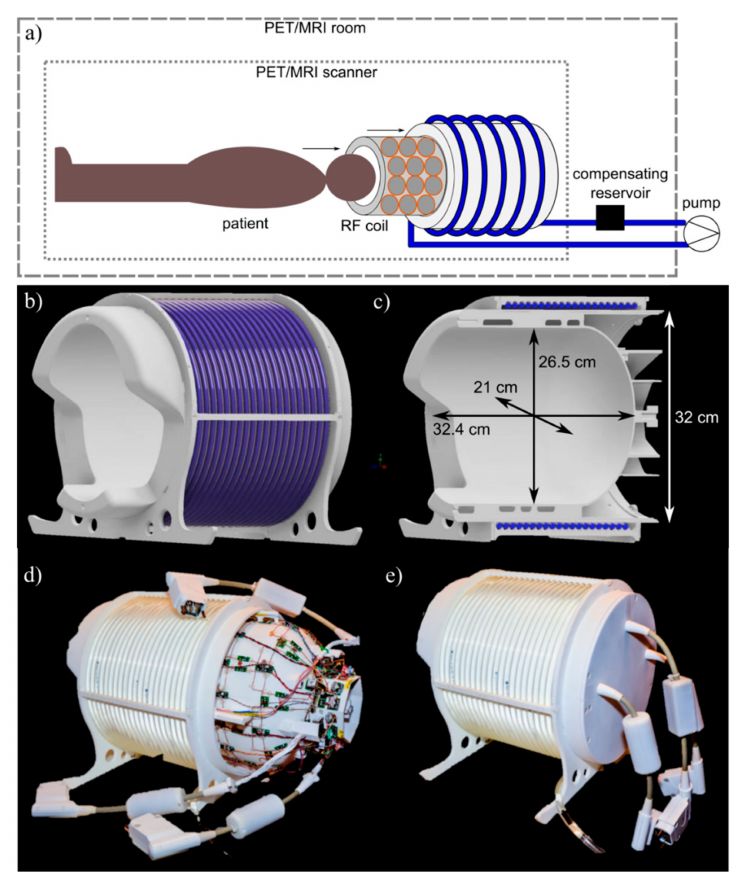
Figure 1. System overview. ( a ) Sketch of the complete setup consisting of transmission source (TxS) system and integrated radiofrequency (RF) receiver array, and its positioning relative to the PET / MR scanner. ( b , c ) 3D CAD drawing of the mechanical support with mounted polyurethane hose. The coil housing is shown in white, and the hose in blue. ( d ) Photograph of the complete RF coil integrated with the TxS system, with RF coil slid slightly out of the surrounding TxS system, and ( e ) in final, mounted